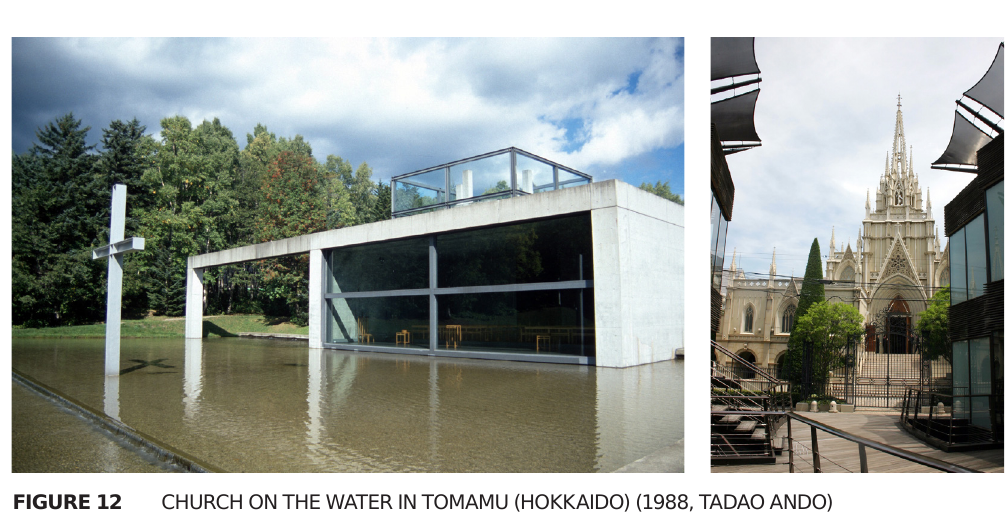
CHURCH ON THE WATER IN TOMAMU (HOKKAIDO) (1988, TADAO ANDO)